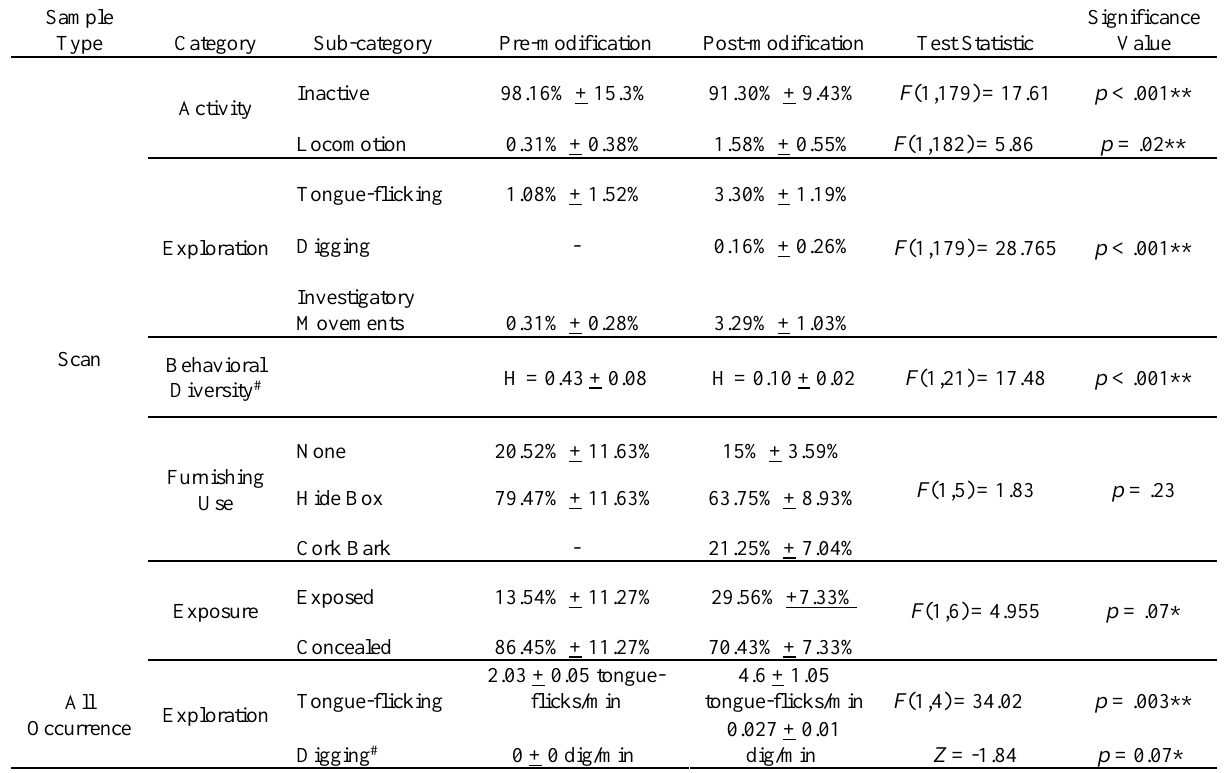
Summary Table Showing all Measures Taken (Behavioral and Space Use) During Observations, Average Percent Time Spent Engaged in Behaviors/space use Measure, and Significance Values Related to Differences Between Baseline and Modified Habitats (for the Group, Excluding